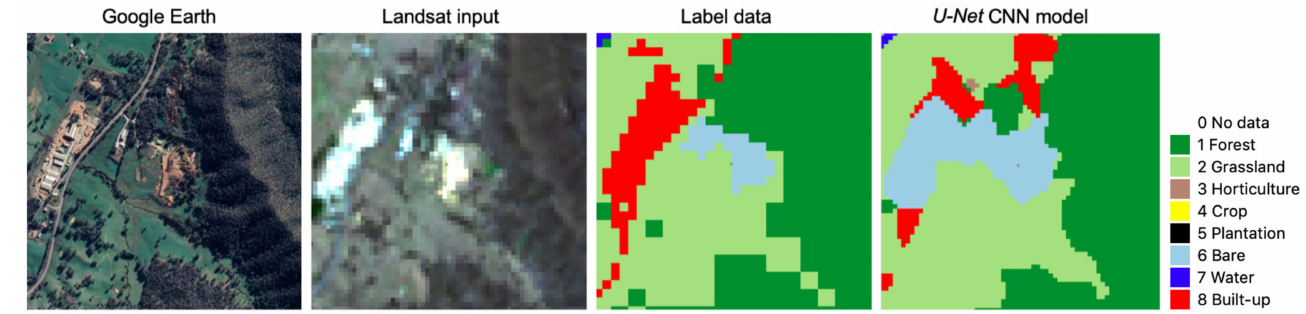
Figure 9. Google Earth, Landsat input (true colour RGB), label data and U-Net CNN model for area (~1.6 km × 1.6 km) centred at 35.33 ◦ S, 148.18 ◦